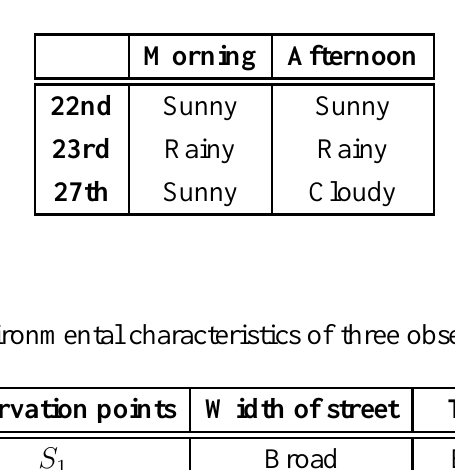
Table 5. Weather condition of three selected days.